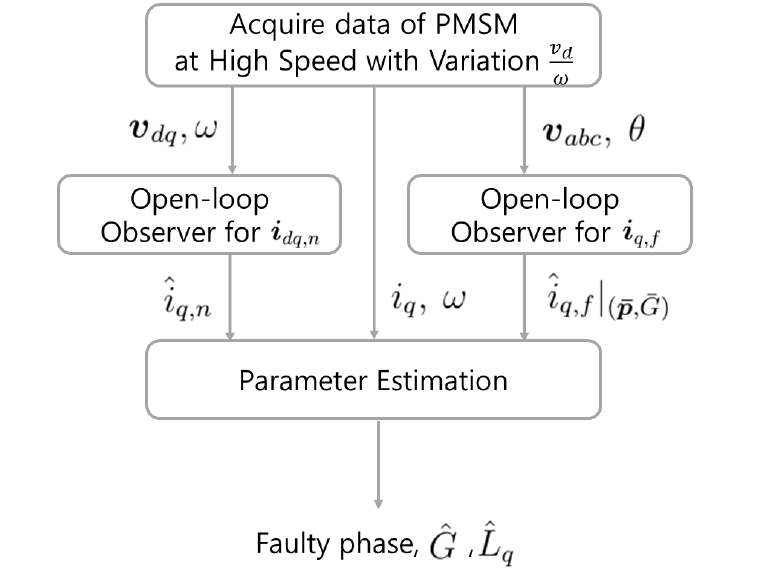
Figure 3. Diagram of proposed